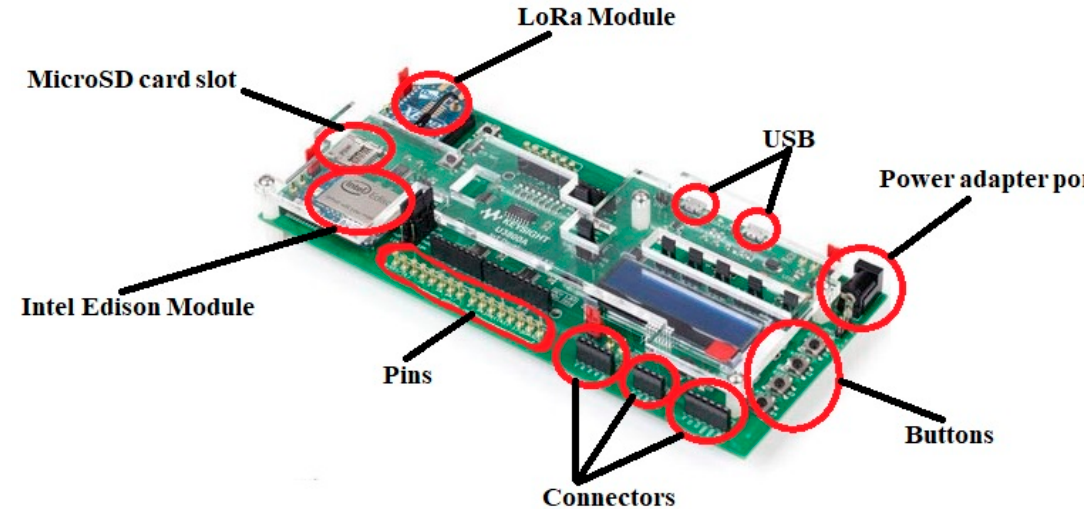
Figure 13. The prototype of the LoRa gateway module